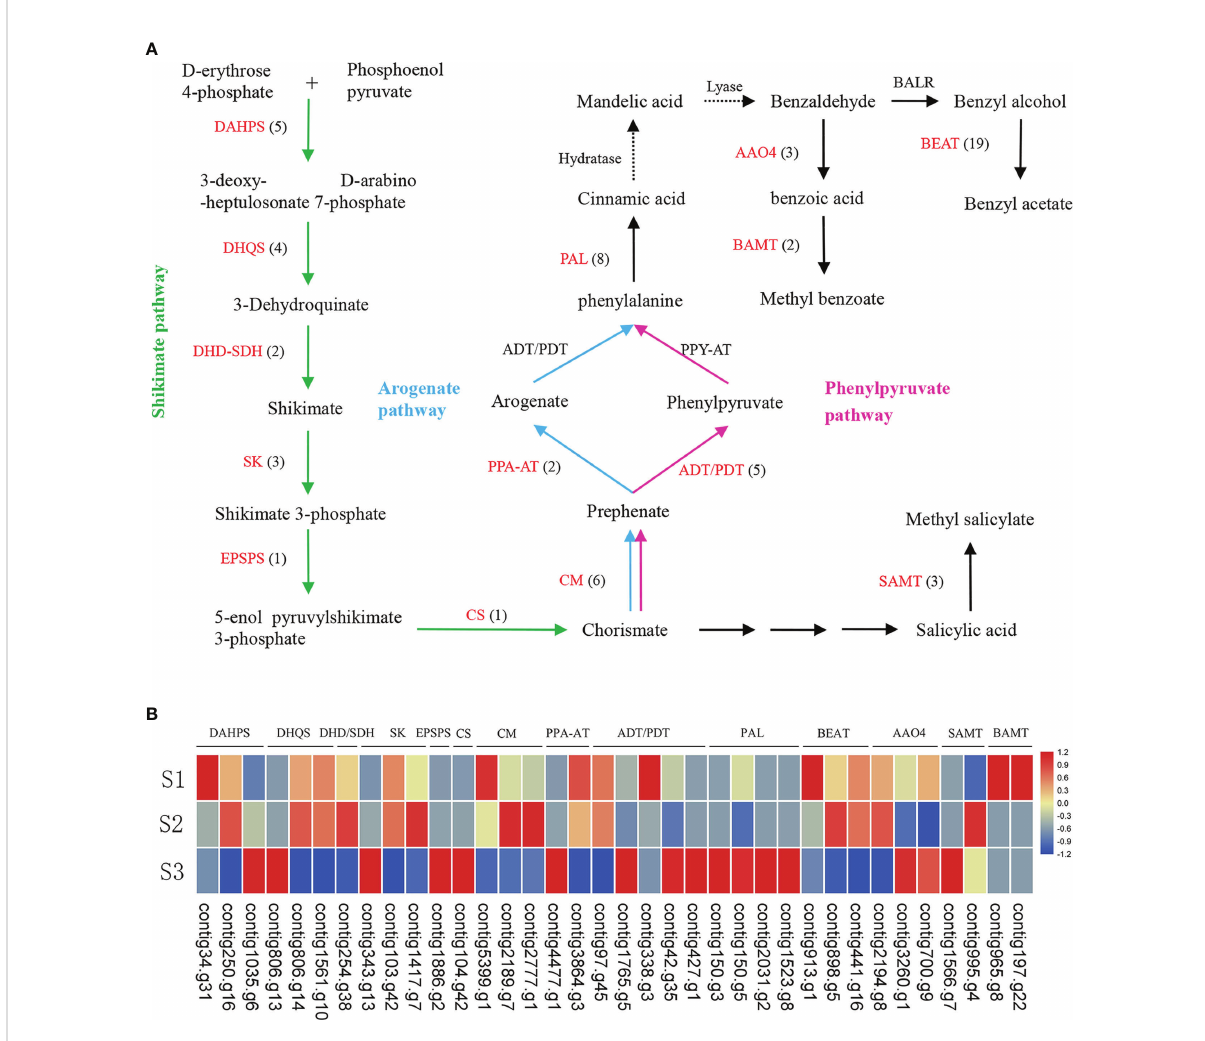
FIGURE 3 The biosynthesis pathways of benzenoid/phenylpropanoid (A) and expression of key genes involved in benzenoid/phenylpropanoid biosynthesis in J . sambac cultivar JSDB (B) . Abbreviations for enzymes in each catalytic step were shown in red letters. The black numbers in parentheses represent the gene number in J . sambac genome. The gradient color for each gene represented the gene expression levels at three fl